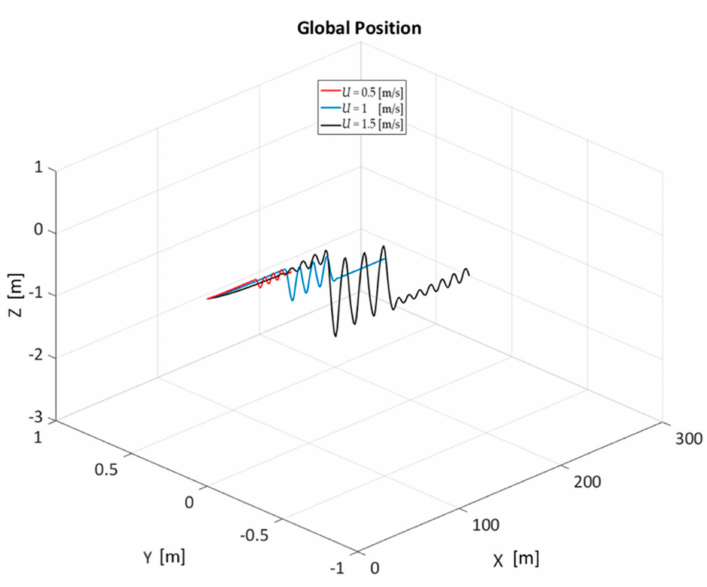
Figure 18. The SFRM’s trajectories in the vertical zigzag test at different sailing